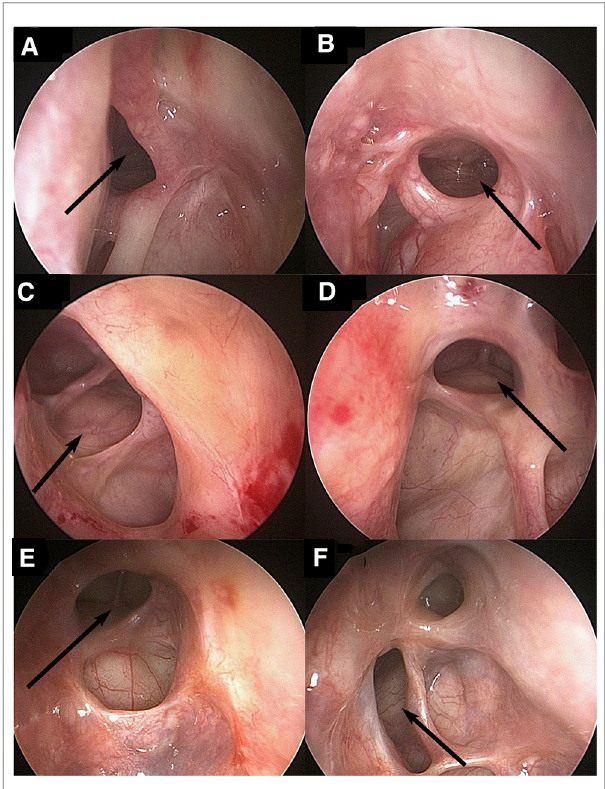
FIGURE 2 Endoscopic view (70° rigid nasal endoscope) of patients 1, 2 and 3 after operation: patient 1 ( A , B ), patient 2 ( C , D ), patient 3 ( E , F ), left ( A , C , E ) and right ( B , D , F ). The arrow indicates the opening of the frontal